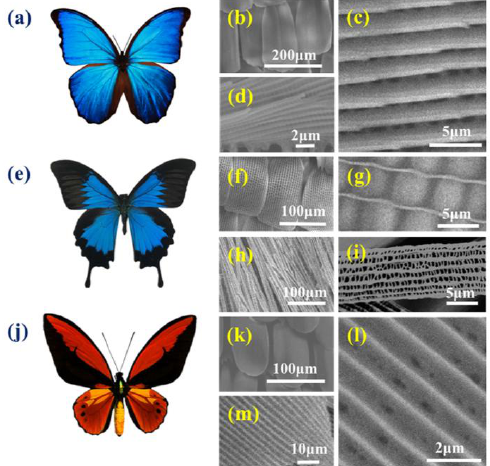
Figure 2. Topographical characterization of the butterfly wings. ( a ) Image of the M orpho menelaus butterfly; ( b – d ) scanning electron microscopy (SEM) images of the microstructure of the M. menelaus wing at different magnifications; ( e ) image of the Papilio ulysses telegonus butterfly; ( f ) SEM image of the microstructure of the blue area of the P. u. telegonus wing and ( g ) higher magnification SEM image; ( h ) SEM image of the microstructure of the fibrous area and ( i ) higher magnification SEM image; ( j ) image of Ornithoptera croesus lydius butterfly; ( k – m ) SEM images of the microstructure of the O. c. lydius wing at different magnifications. Biomimetics 2018 , 3 , 2